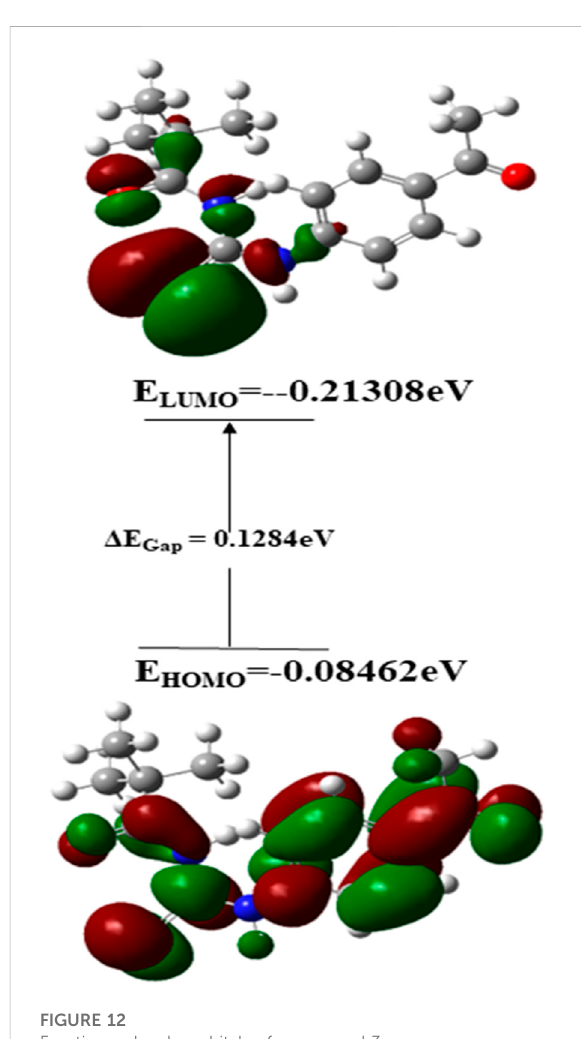
FIGURE 12 Frontier molecular orbitals of compound